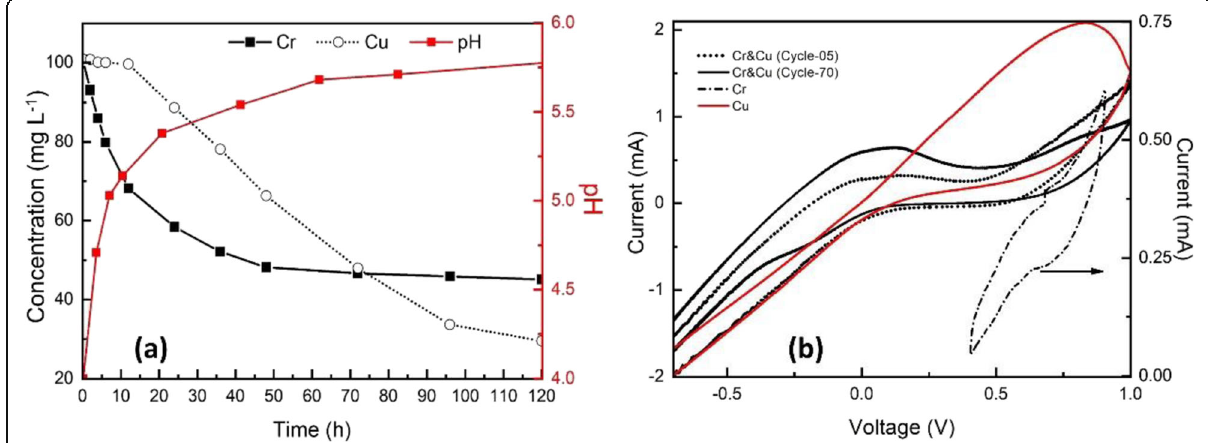
Fig. 4 a Temporal behavior of Cr 6+ and Cu 2+ and corresponding change in the pH value at pH 4; b Cyclic voltammograms of CC electrode in Cu 2+ , Cr 6+ , and Cr 6+ & Cu 2+ mediated solution at pH 4